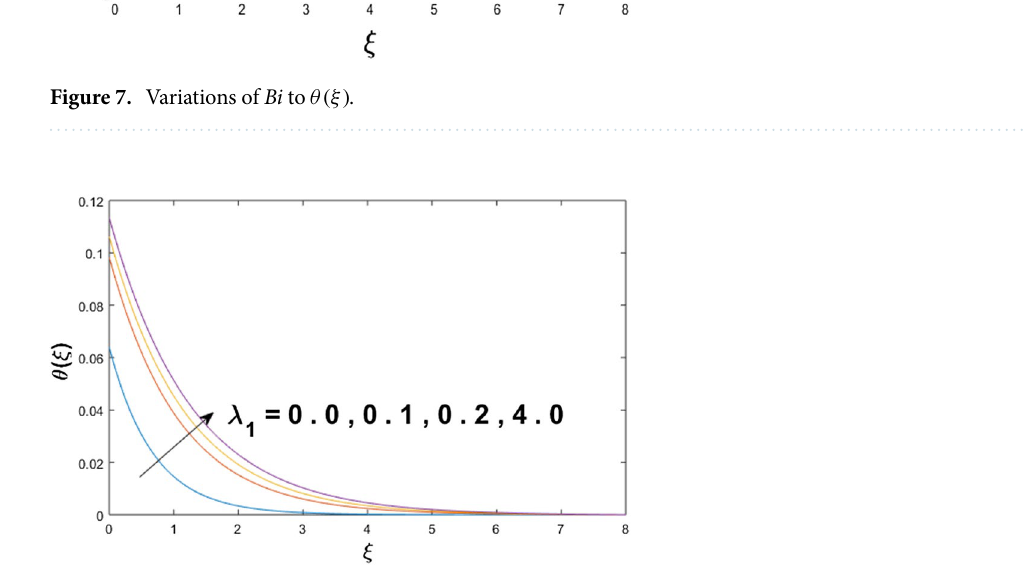
Figure 8. Variations of (cid:31) 1 to θ(ξ)